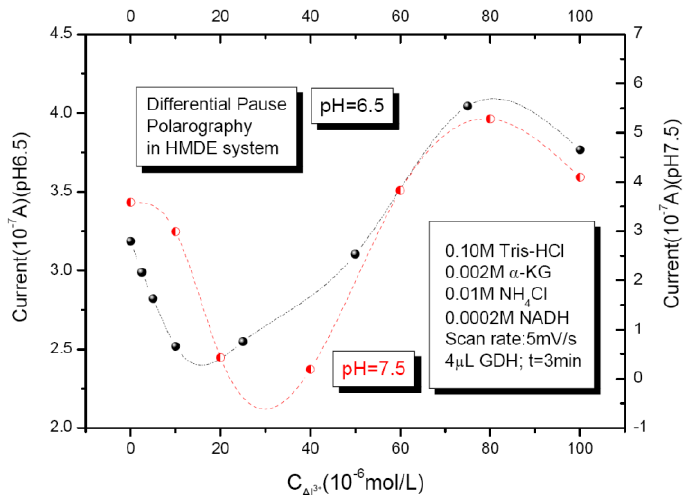
Figure 11. DPP peak currents as a function of Al (III) concentration; in 0.1 M pH = 6.5 and 7.5 Tris-HCl buffer solutions; 0.002 M α-KG; 0.01 M NH GDH; measurement time 3 min; Scan rate: 5 mV/s. Reprinted from reference [47] with permission from